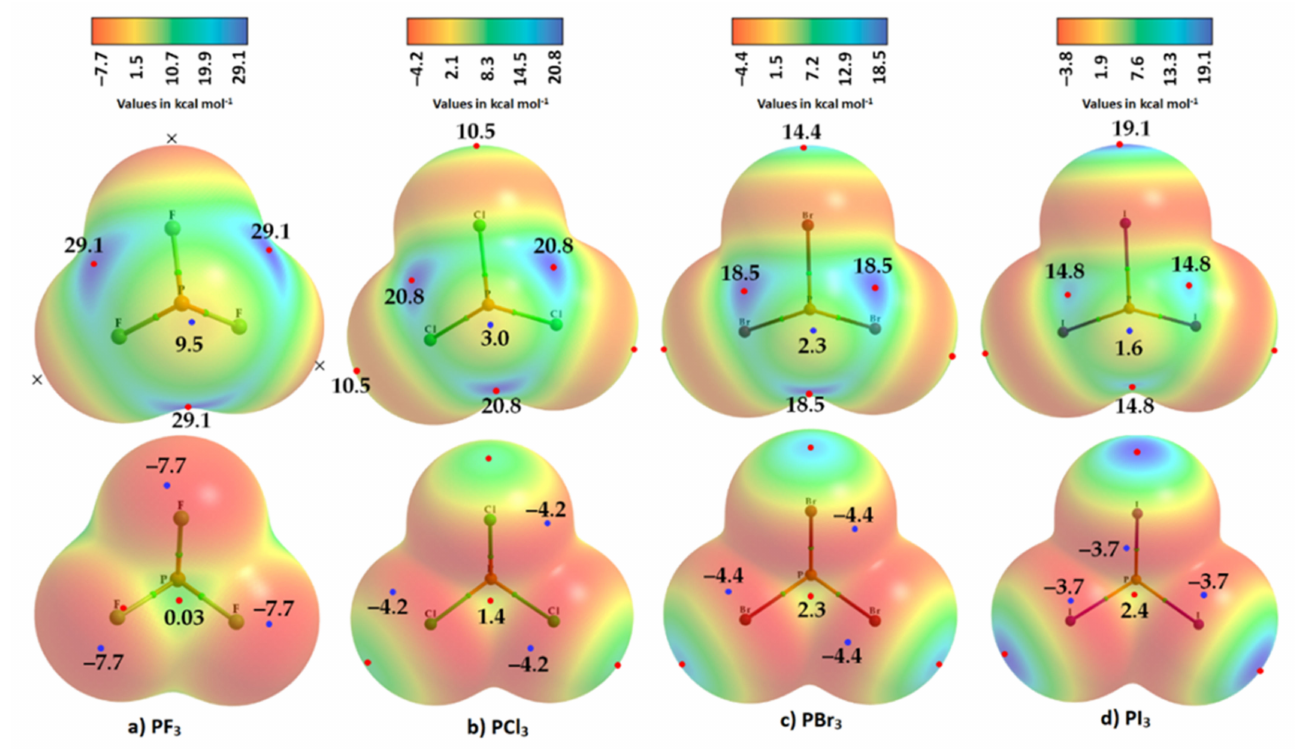
Figure 5. Comparison of MP2(full)/def2-TZVPD calculated 0.001 a.u. isodensity envelope mapped potential on the electrostatic surfaces of PX 3 (X = ( a ) F, ( b ) Cl, ( c ) Br, ( d ) I) molecules. Selected V S,max and V S,min values in kcal mol − 1 are shown, which are the local maxima and minima of potential, respectively. Two views of each MESP graph for each molecule are displayed: (Top) Covalently bonded P faces the reader. (Bottom) The three X atoms forming a triangular architecture face the reader. The QTAIM-based molecular graphs are superimposed on each case, and the bond paths are in atom color, accompanied by bond critical points (tiny sphere in